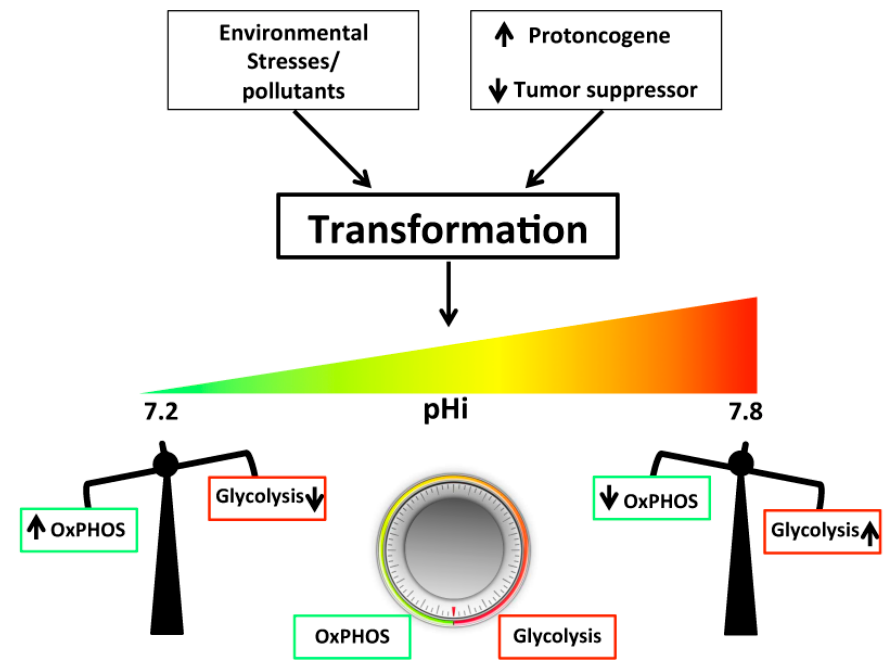
Figure 1. Among all the many allosteric factors controlling glycolysis, the cytosolic pH is in all probability the most significant factor regulating the metabolic balance. In the presence of adequate oxygen levels, the intracellular pH (pHi) plays a crucial role in determining the way cancer cells obtain energy: An alkaline pHi driving aerobic glycolysis, and a neutral pH driving oxidative phosphorylation with the cells pH transporters, ion channels, and enzymes, representing the core of this sophisticated and coordinated system (see text). An explanation for this phenomenon derives from the fact that both the processes of oxidative phosphorylation (OxPHOS) and glycolysis are exquisitely but oppositely pH-sensitive, and a rapid shift of metabolic cell patterns follows either acidification or alkalinization of the cytosol. On the basis of the studies discussed in this review, we can now see that the alkalinization of the cytosol occurs in the very first steps of oncogene-driven neoplastic transformation and is probably the fundamental physiological alteration utilized by the increased expression/activity of an oncogene or decreased expression/activity of a tumor suppressor to transform a normal cell. In this way, cytosolic pH would regulate the cells’ metabolic balance as a rheostat, as described in the general scheme imagined by DeBerardinis and Chandel [33], where instead of the usual on or off ‘switch’ between glycolysis and OxPHOS, they hypothesized the existence of a continuum between the two but did not have a physiological mechanism that could underlie this proposed rheostat-like mechanism.